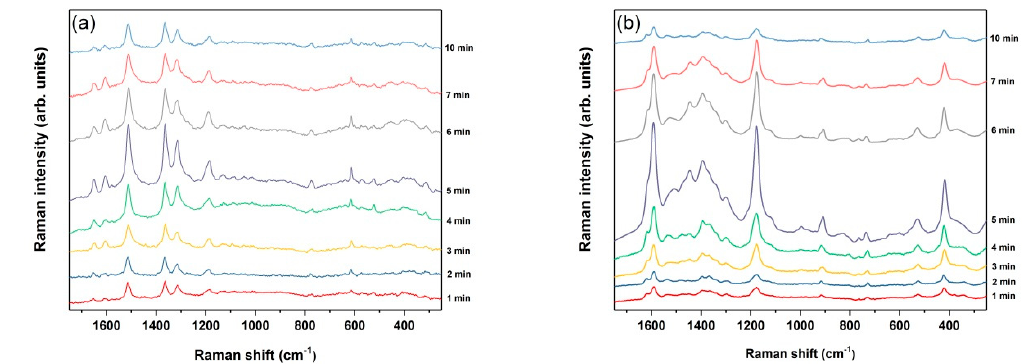
Figure 7. The SERS spectra of 10 − 4 M ( a ) R6G (25 scans, 250 mW) and ( b ) CV (50 scans, 500 mW) molecules deposited on RF S2 samples immersed in 10 − 2 M AgNO 3 for different times (1 to 10 minutes from bottom to top). Spectra are offset along the y -axis for clarity.